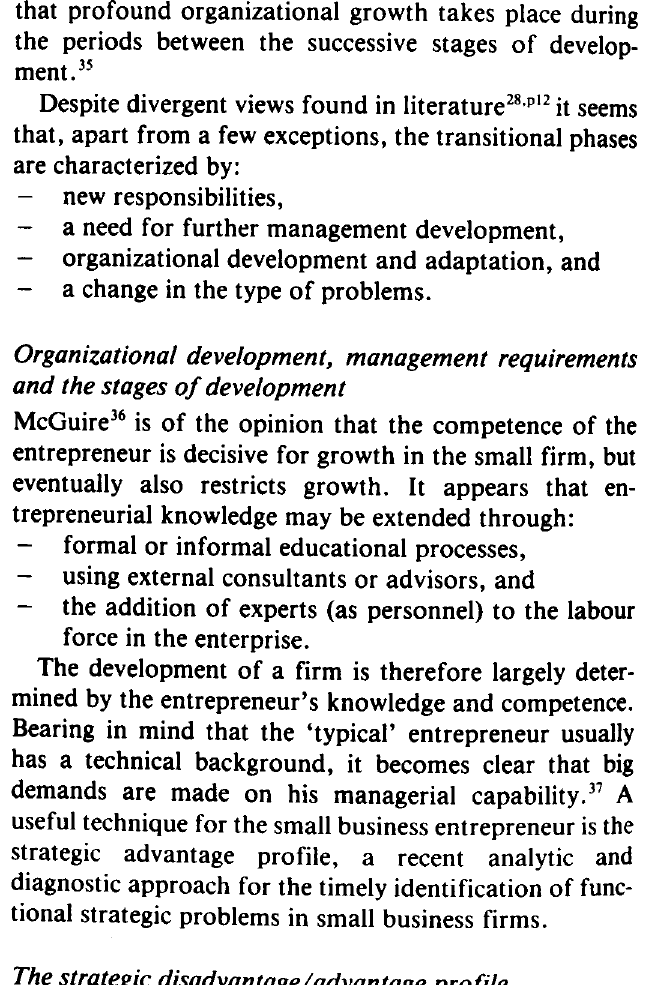
Figure 1 Institutional life cycle (Vozikis, op.cit., p.24)